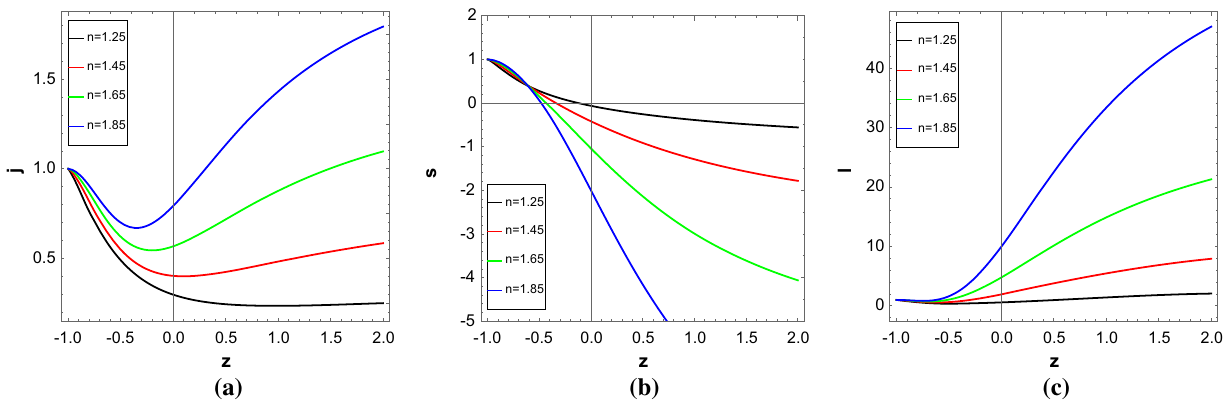
Fig. 5 The plots of jerk j , snap s and lerk l parameters vs. redshift z ∀ n , which is consistent with observations of standard (cid:3) CDM but at present z = 0, j (cid:10)= 1, ∀ n . Therefore, our model is sim- ilar to the dark energy model, different from (cid:3) CDM, ∀ n , at the present time. Figure 5b enacts the profile of snap param- eter s during its evolution. In the early Universe s assume value in the negative range ∀ n then as Universe evolves, s take values in the positive range, i.e. in the entire evolution of s , there is one transition from negative to positive